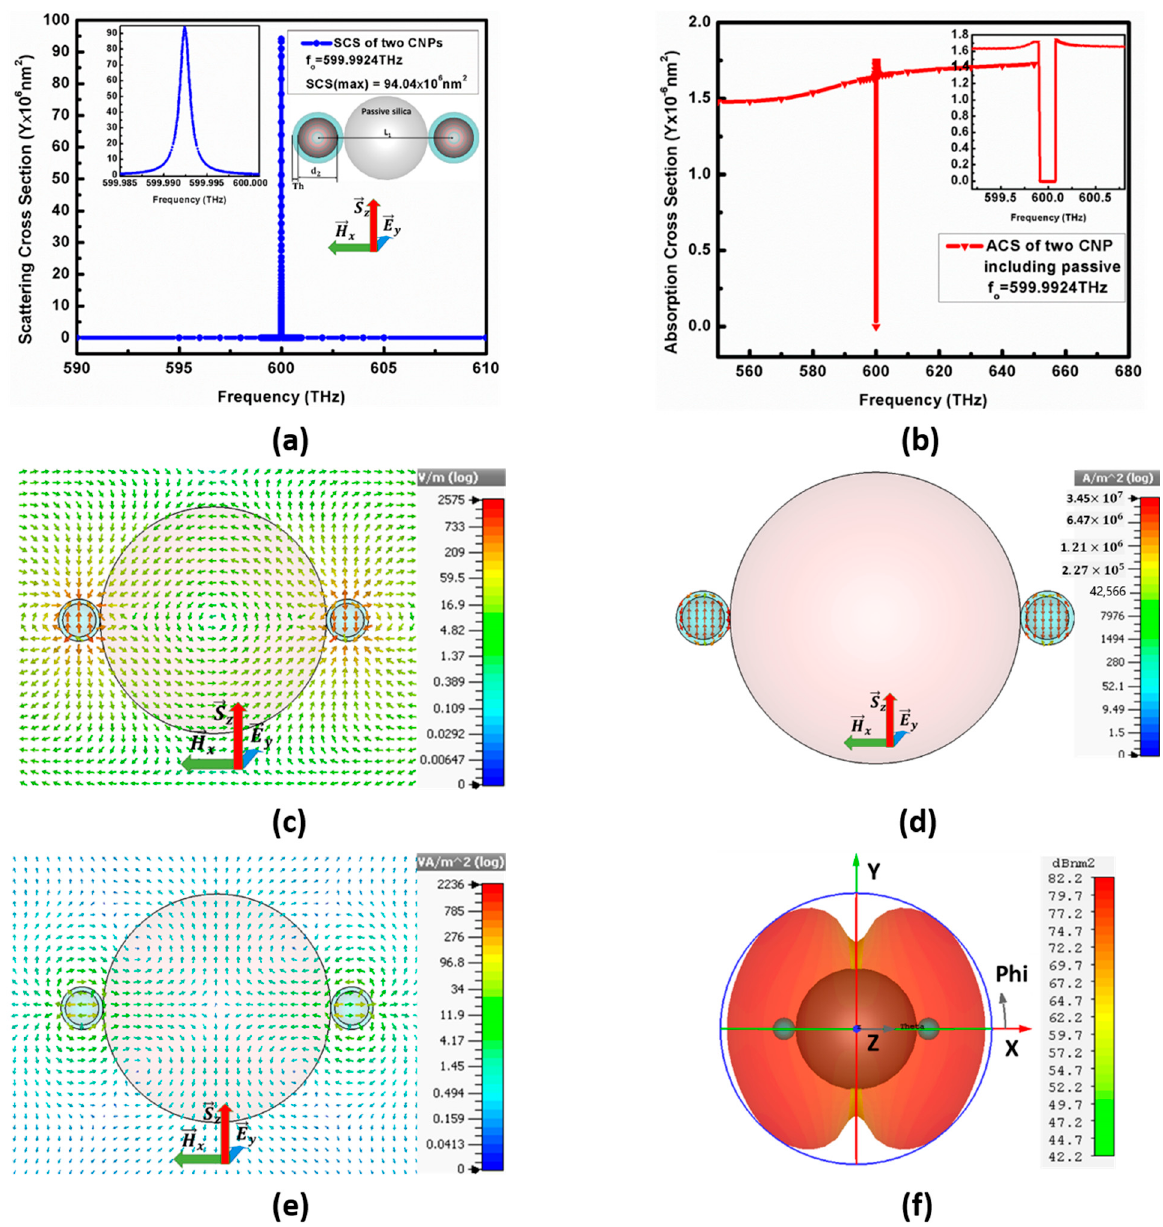
Figure 6. Represents ( a ) SCS of configuration-II, ( b ) ACS, ( c ) electric field spectrum, ( d ) current density ( e ) power flow and ( f ) far-field pattern for configuration II. 3.3. (cid:2161)(cid:4652)(cid:4652)(cid:1318) (cid:2208) Polarized Plane-Wave Excitation Propagating along the x-axis